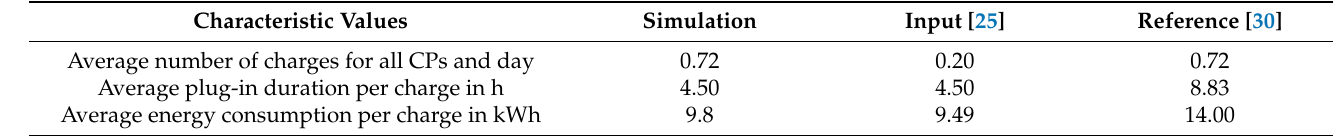
Table 5. Modeled results compared with input data and data for